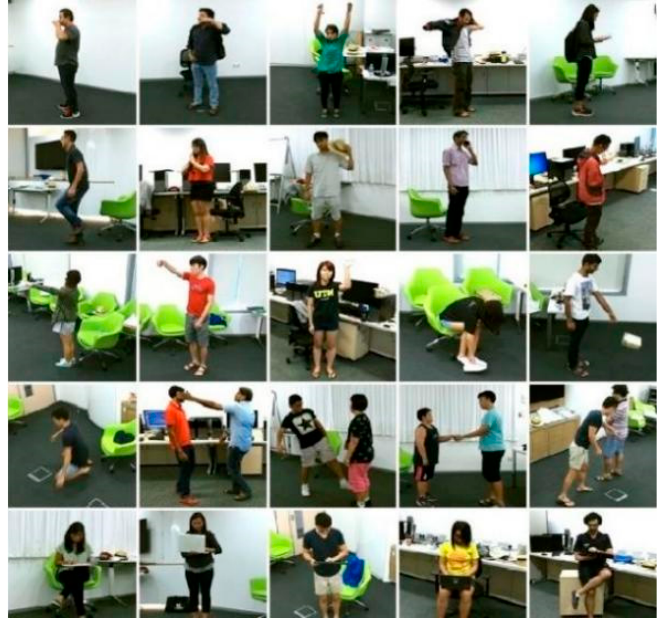
Figure 6. NTU RGB+D 60 dataset partial sample data.